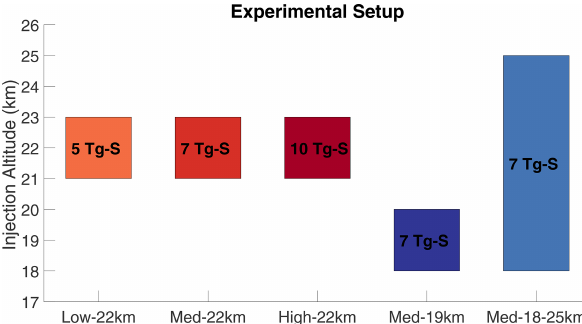
Figure 1. Graphical representation of injection setting parameters. The reddish boxes represent an injection of 5, 7, and 10TgS in the form of SO 2 centered at 22km; the blue and light-blue boxes represent the injection of 7TgS in the form of SO 2 for injection altitudes centered at 19km and one deep injection between 18 and